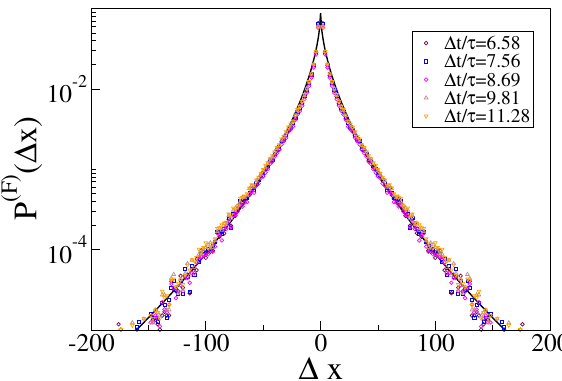
Figure 9: Normalized probability distributions P ( F ) ( ∆ x ) , as obtained normalizing the Van Hove after removing the δ in the origin, at different times. The excellent collapse of the distri- butions confirms that in the considered temporal range the Van Hove distribution is dominated by the escaped particles. The two parameters fit Eq. 40 is in very good agreement with data. which